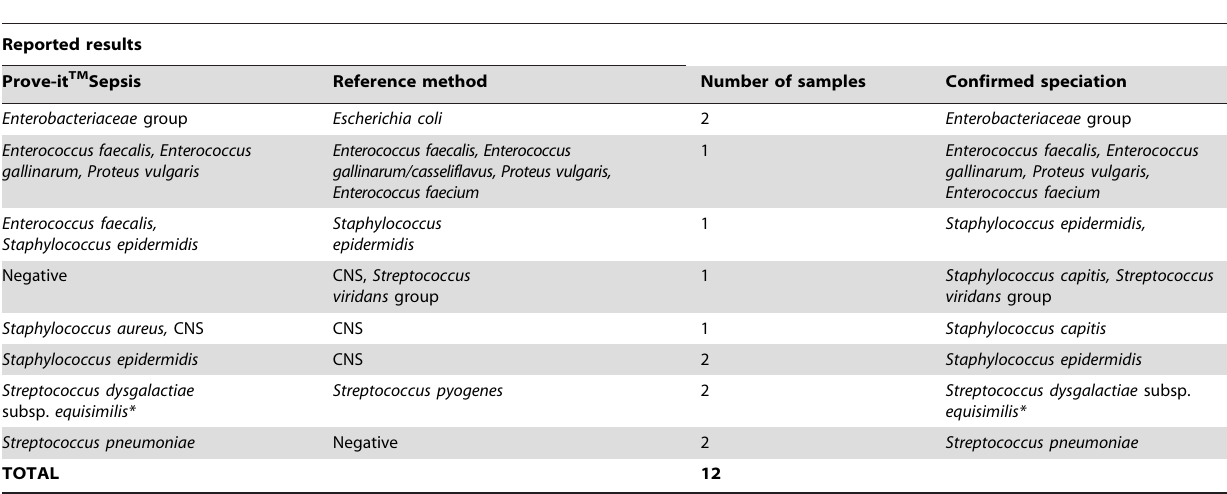
Table 2. Identification discrepancies of blood culture samples between the reference method and Prove-it TM Sepsis categorized on the basis of reported results.